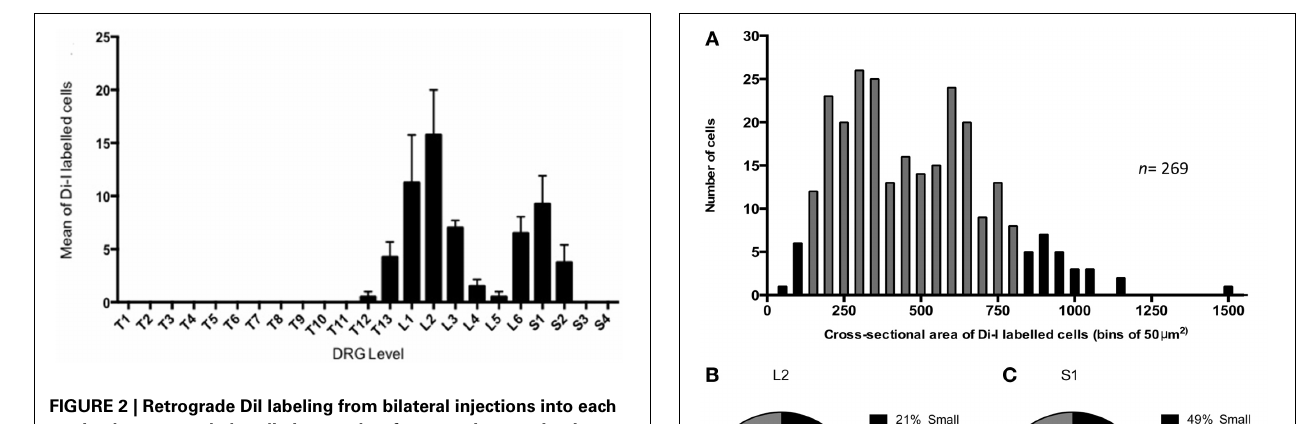
FIGURE 2 | Retrograde DiI labeling from bilateral injections into each uterine horns revealed to distinct peaks of sensory innervation in Dorsal Root Gangli. The mean number of DiI labeled cells is plotted against the spinal DRG level in which they were observed. The counts of four animals were averaged at each level.